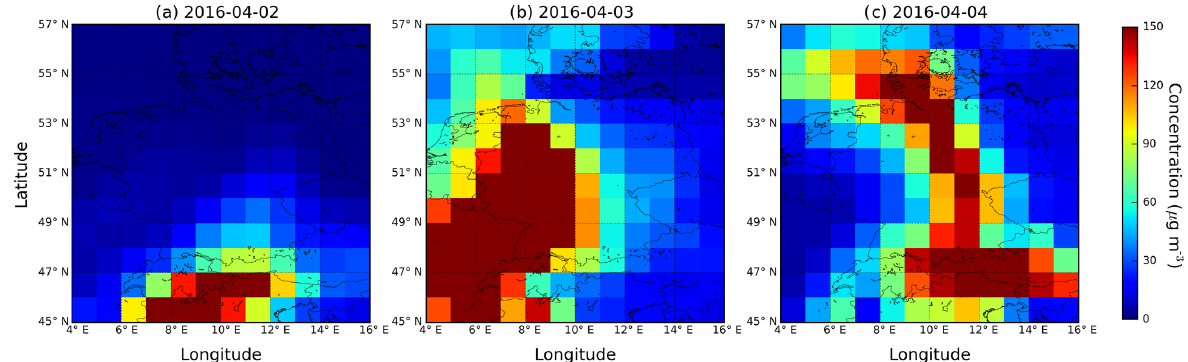
Figure 9. Dust concentration (averaged over the lowermost kilometer of the troposphere, in µgm − 3 ) over Germany as predicted from the IFS model: 2 to 4 April 2016 (from left to right), 12:00UTC.